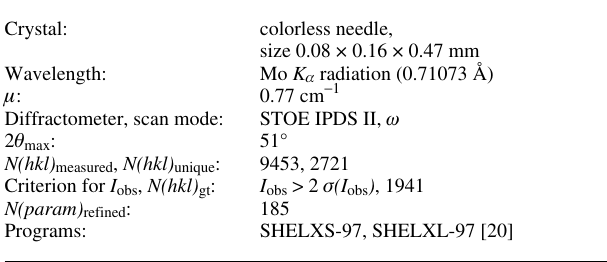
Table 1. Data collection and handling.